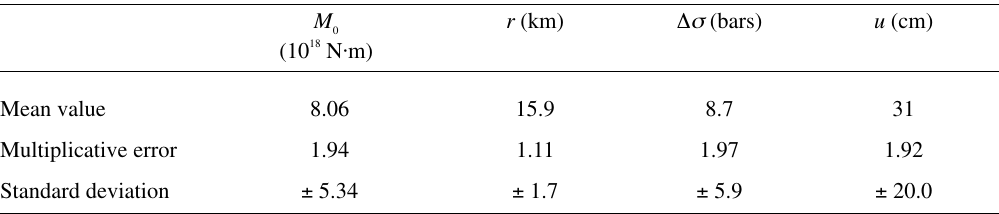
Table III. Mean values and multiplicative error factors of the seismic moment, M drop, (cid:54)(cid:109) and the average displacement, u , as defined by means of the far-field P -wave spectral analysis.